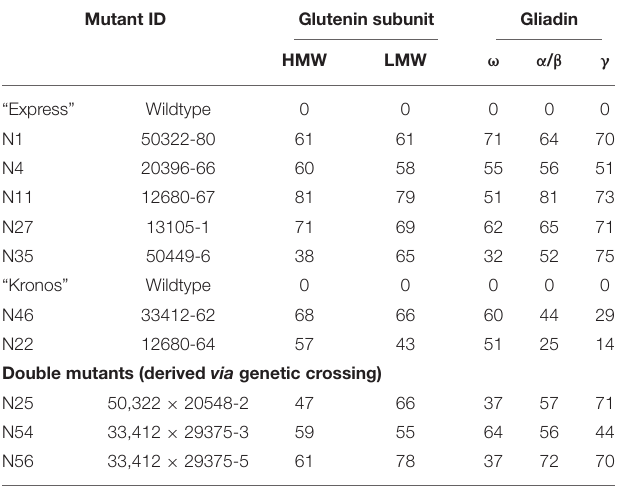
DRE2 2AL homoeologue). Further, some mutants exhibited over- TABLE 2 | List of selected mutants in the wheat DEMETER genes showing reductions (in percent) in the content of various gluten proteins. accumulation of HMWgs (range from 1.3 to 5.5 fold) and LMWgs (range from 1.1 to 2.2 fold), whereas some Mutant ID Glutenin subunit Gliadin HMW LMW ω α / β γ